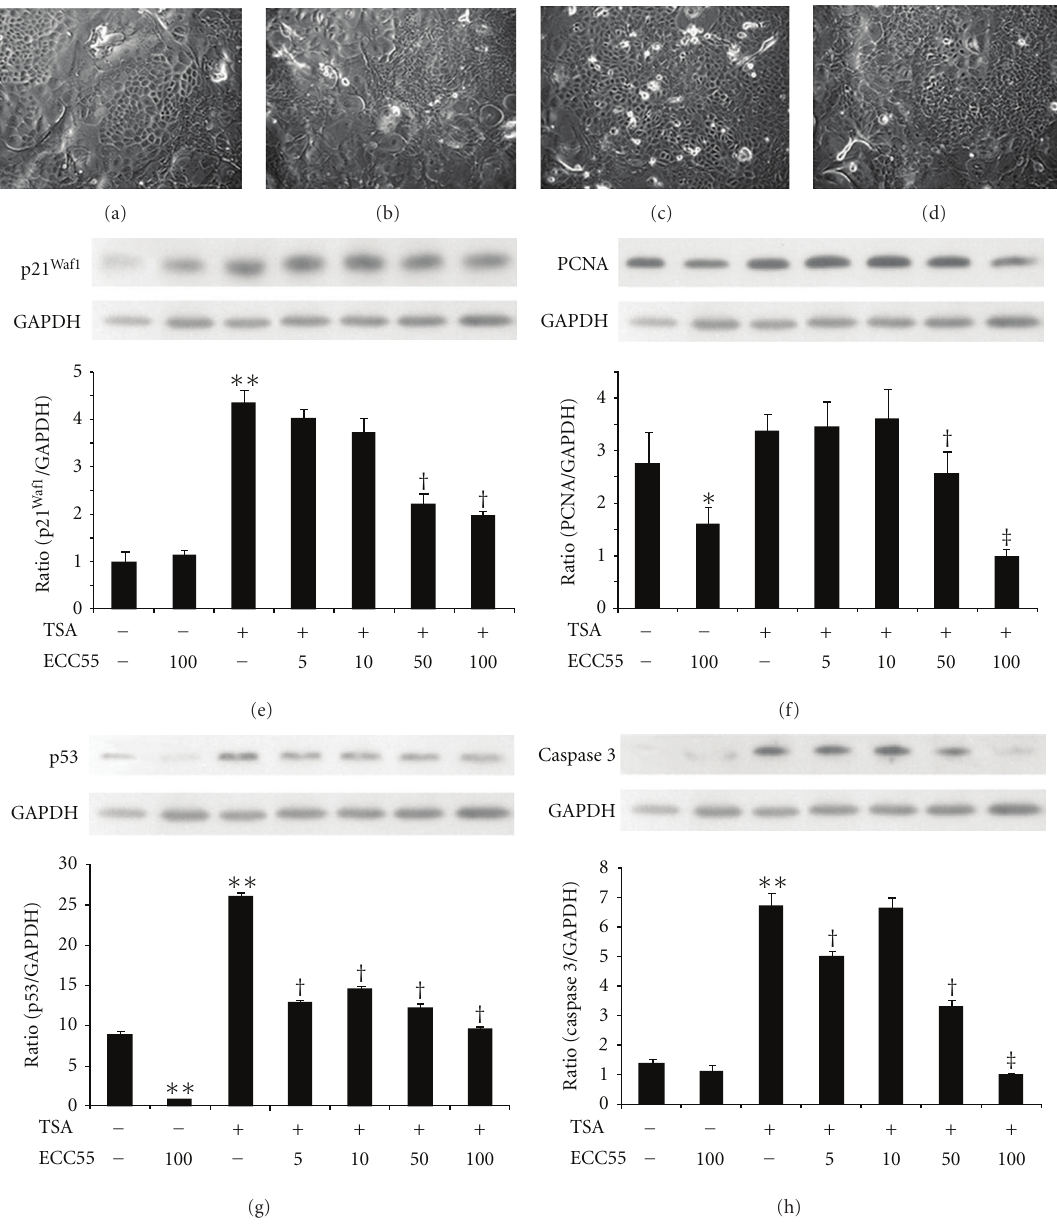
Figure 4: E ff ects of concentrated ethanol extract of Edelweiss callus cultures (ECC55) on Trichostatin A-induced cellular senescence and molecular markers of apoptosis, cell cycle, and proliferation. (a)–(d). Phase contrast microphotographs of cultivated human keratinocytes: untreated control (a), treated with Trichostatin A alone (b), treated with ECC55 alone (c), and treated with a combination of Trichostatin A and ECC55 (d). (e) Western blots and their densitometry showing p21 expression upon treatment with 100 μ g/mL ECC55 alone, Trichostatin A (TSA) alone, or TSA combined with increasing concentrations of ECC55 (5–100 μ g/mL). (f) The same for proliferation-connected nuclear antigen (PCNA). (g) The same for p53 and (h) for caspase 3. Error bars in all figures correspond to S.D. ∗ P < 0.05 and ∗∗ P < 0.01 versus untreated control; † P < 0.01 and ‡ P < 0.001 versus TSA-treated